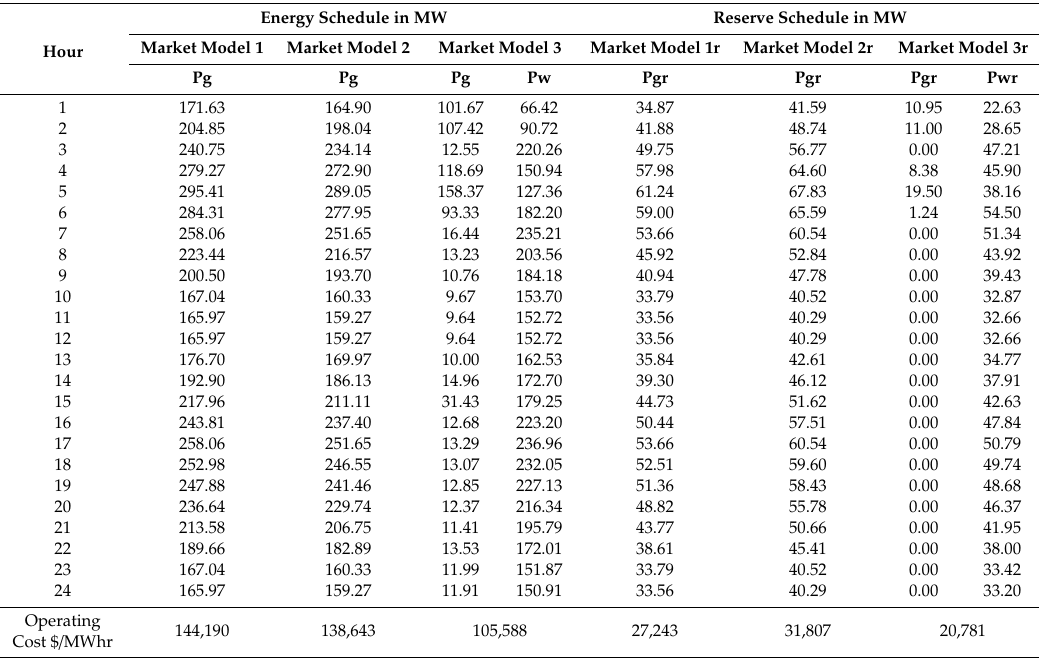
Table 1. Comprehensive energy and reserve schedule of various LSEs.